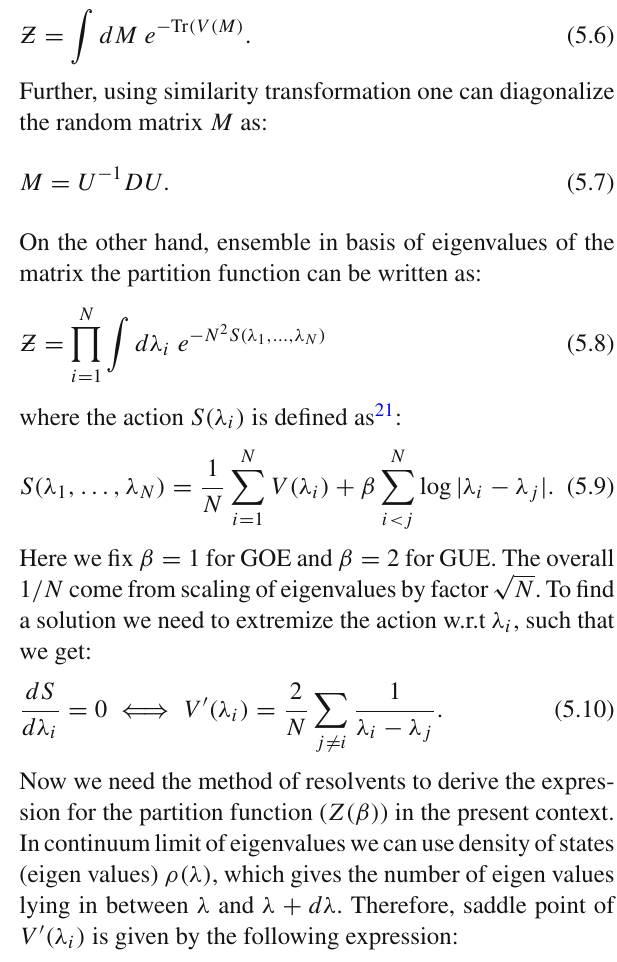
Table 2 Properties of Gaussian matrix ensemble in random matrix theory (RMT) Element of matrix Type of ensemble Relation Elements are real Gaussian orthogonal ensemble Time reversal symmetric Hamiltonian Elements are complex Gaussian unitary ensemble Broken time reversal symmetric Hamiltonian Elements are quaternion Gaussian symplectic ensemble